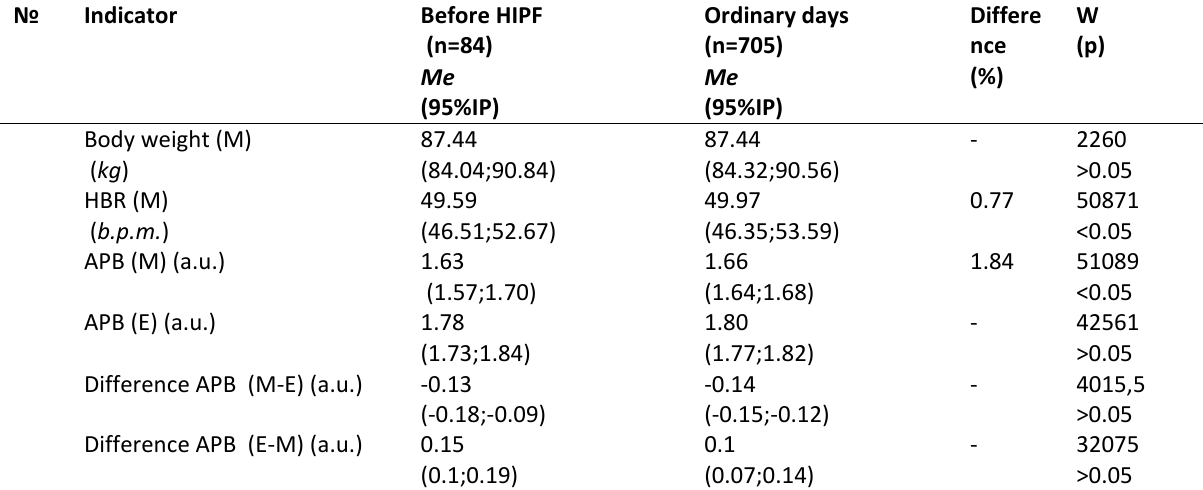
Table 3. Comparing of men’s PC indicators before HIPF days with indicators of ordinary days днями №